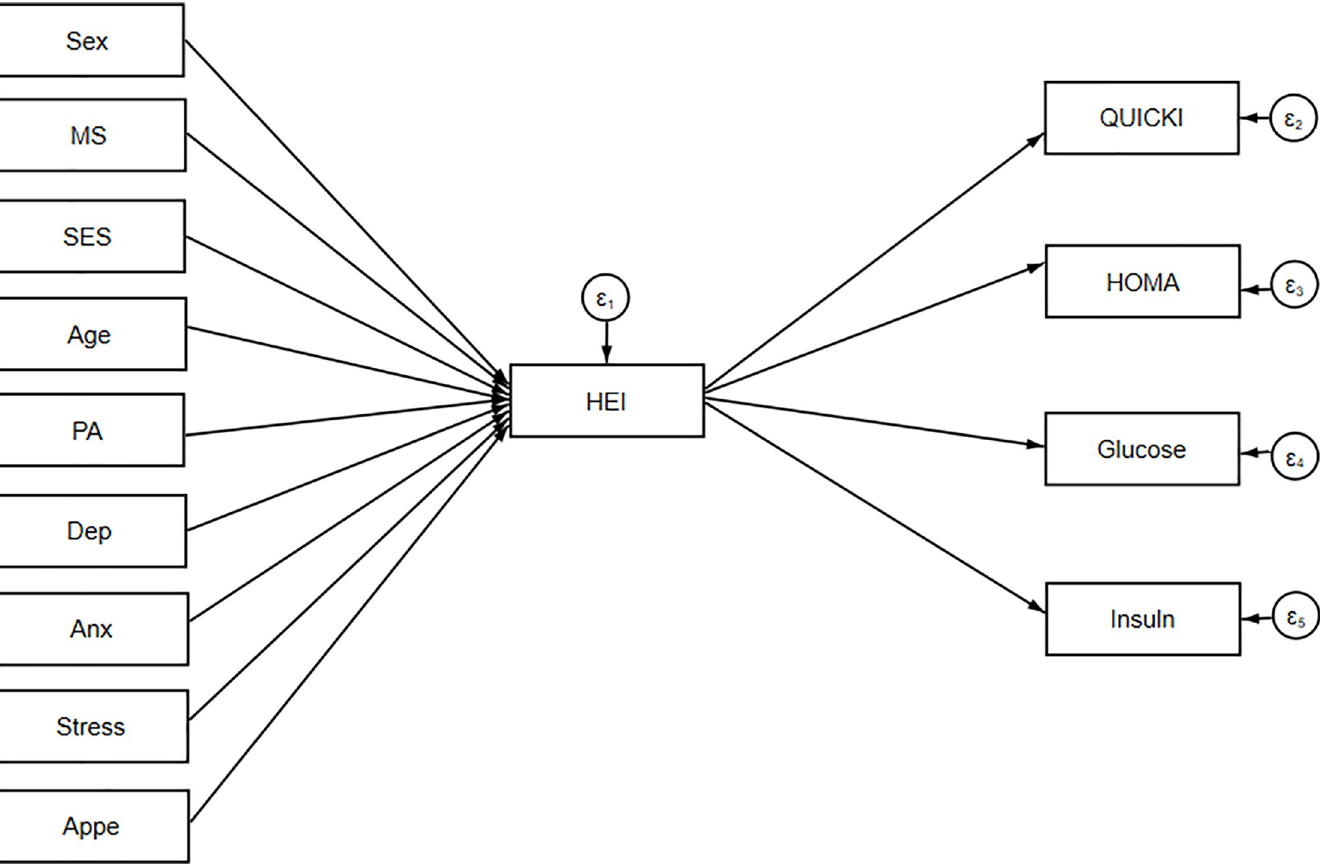
Fig 1. Hypothesized models in which HEI as a mediating variable relates socio-demographic variables and mental health to insulin resistance indices. Abbreviations: HEI, healthy eating index; HOMA, homeostasis model assessment; QUICKI, quantitative insulin sensitivity check index; SES, socio-economic status; PA, Physical activity; MS, marital status; Anx, anxiety; Dep, depression; Appe, appetite.